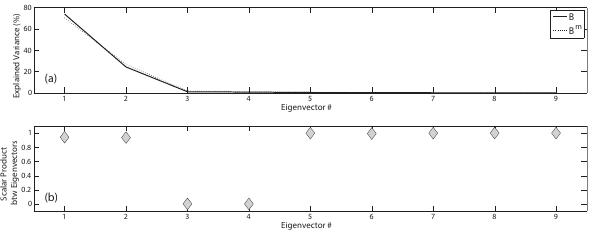
Fig. 7. (a) Explained variance over each eigenvector of B m used in LSI (dotted line; see text) and the actual background error co- variance matrix B (solid line). (b) Scalar product between pairs of eigenvectors of B m and B .